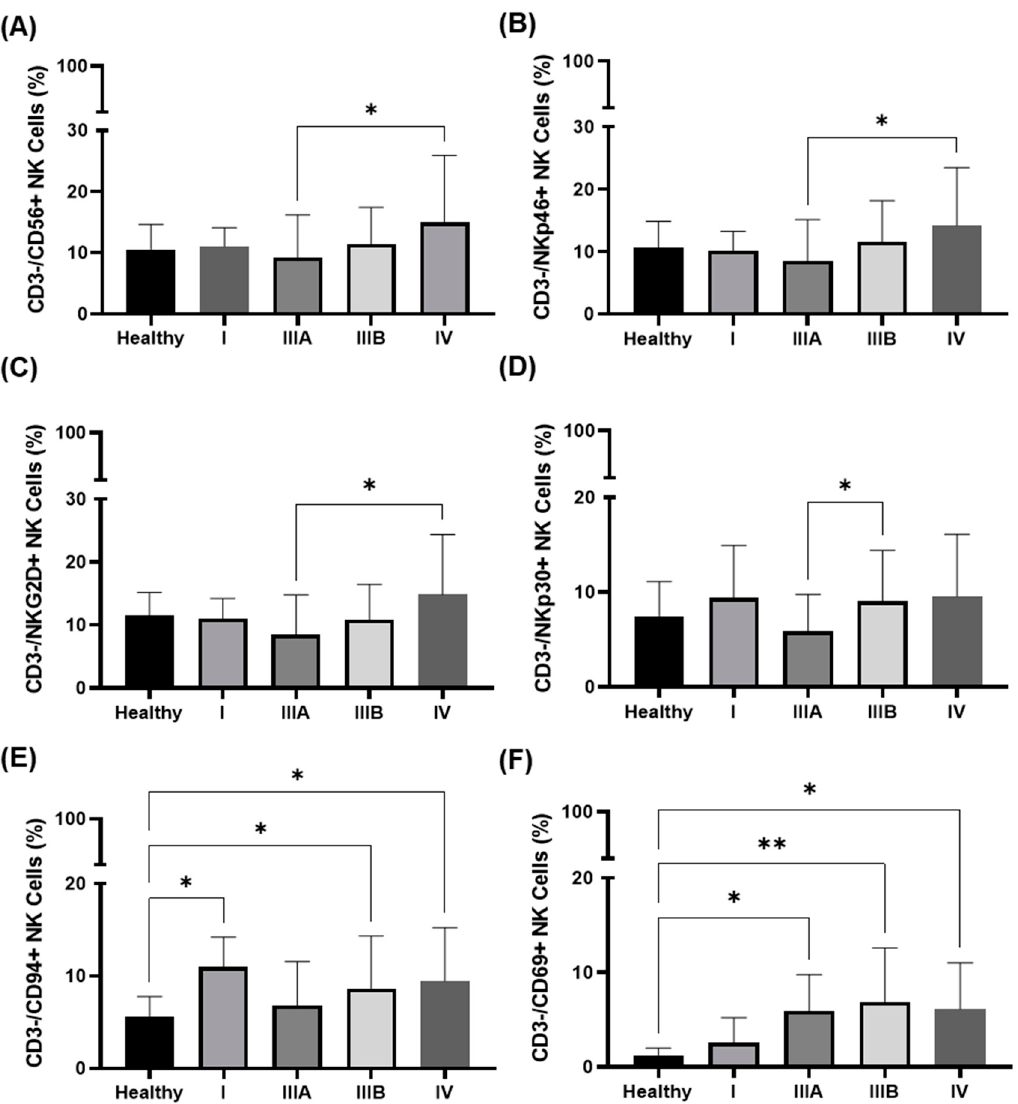
Figure 4. Frequency of NK cell subsets in the peripheral blood of healthy volunteers vs. NSCLC patients as determined by multiparameter flow cytometry. ( A ) The proportion of CD3 − /CD56+, ( B ) CD3 − /NKp46+, and ( C ) CD3 − /NKG2D+ NK cells are significantly increased from UICC stage IIIA ( n = 32) to IV ( n = 42) (* p < 0.05). ( D ) The proportion of CD3 − /NKp30+ NK cells is significantly increased from stage IIIA to IIIB. No significant differences were detected in these NK subsets in healthy volunteers vs. NSCLC patients in all different UICC stages ( n = 113). ( E ) The proportion of CD3 − /CD94+ NK cells are significantly increased in NSCLC patients in UICC stage IIIB compared to that of healthy volunteers. ( F ) The proportion of CD3 − /CD69+ NK cells in NSCLC patients gradually and significantly increased compared to that of healthy volunteers. Statistically significant differences were * p < 0.05 and ** p < 0.01.